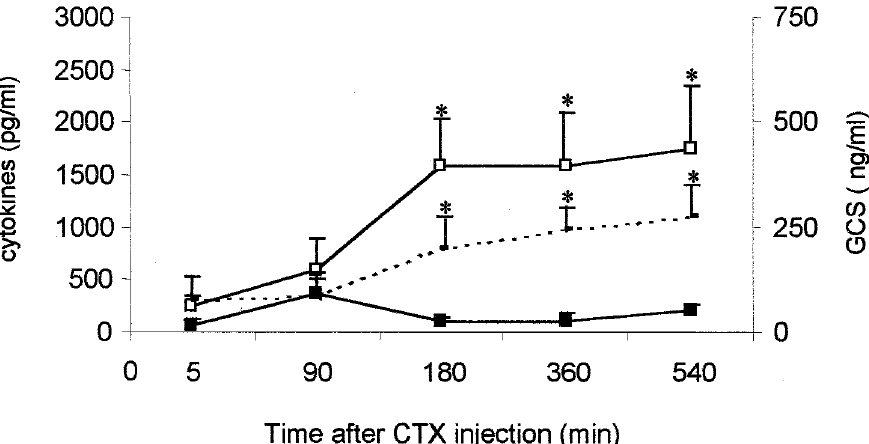
FIG. 2. Effects of crotoxin (CTX) on in vivo cytokine and corticosterone secretion. Animals were treated with CTX (5 m g/100 m l, subcutaneously) or equivalent volume of bovine serum albumin (BSA), and blood was collected from orbital plexus at varying intervals of time after injections. Cytokine and corticosterone serum levels were determined by enzyme-linked immunosorbent assay and radioimmunoassay, respectively. Values represent the mean ± SD of 12 animals. ( j ) IL-10 concentrations, ( h ) IL-6 concentrations and (– –) corticosterone levels. * p < 0.05 in comparison with initial values and with values obtained in BSA- treated animals. GCS,